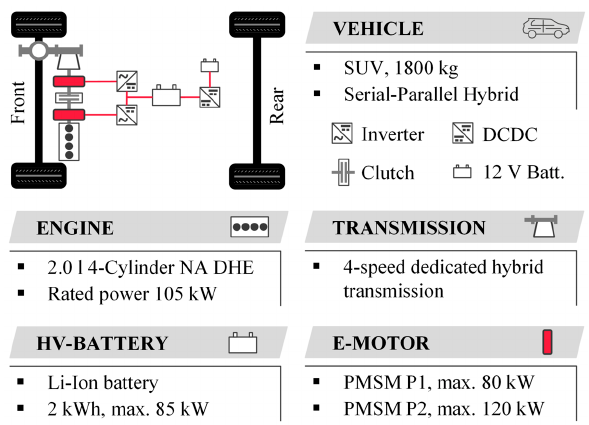
Figure A1. Powertrain layout and component specification.